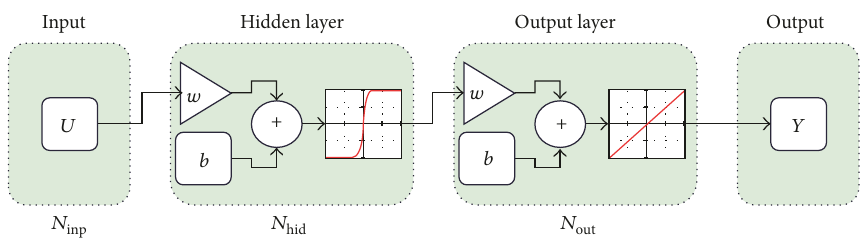
Figure 2: Feed-forward neural network with 𝑁 inp number of inputs, with 𝑁 hid neurons in hidden layer and with 𝑁 out outputs.